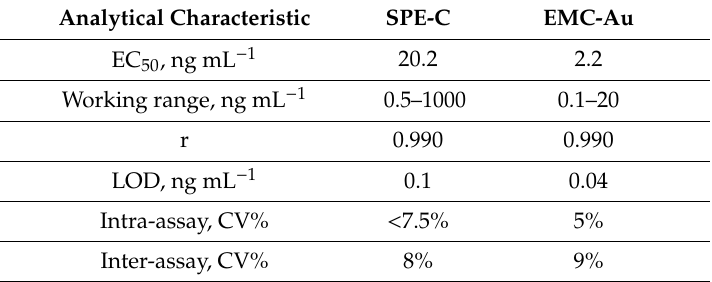
Table 2. Analytical characteristics for procalcitonin (PCT) determination using both approaches: SPE-C and